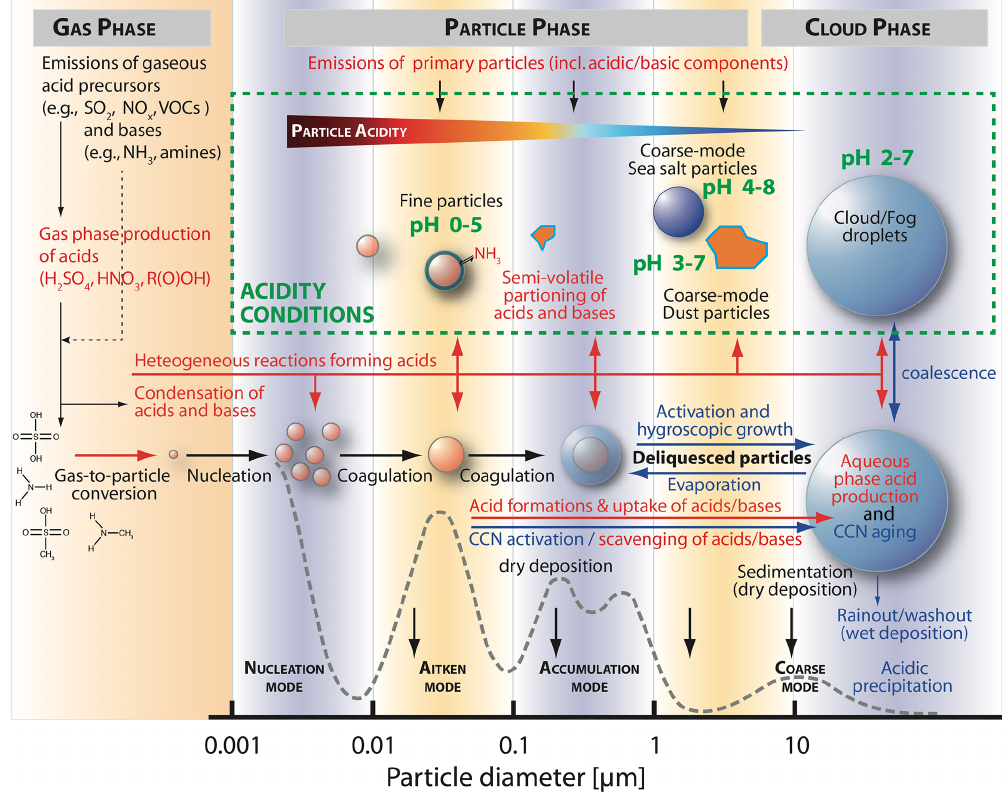
Figure 5. Schematic of sources (red text) and conditions of acidity in different aqueous aerosol particles (green text) together with micro- physical and chemical processes that are able to influence the acidity of tropospheric aerosols (created after Raes et al., 2000, and McMurry, 2015). The blue text describes microphysical processes of CCNs and cloud and fog droplets. The dashed gray line represents an aerosol number size distribution, based on McMurry